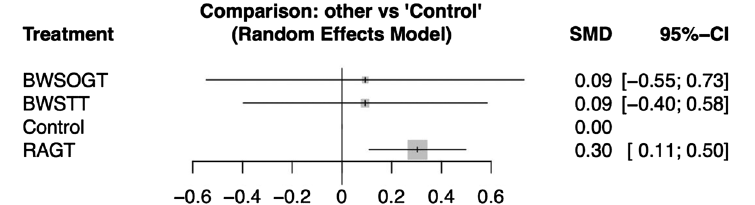
Figure 4. Forest plot of ambulatory assessments. The SMDs and 95% CIs of comparison between the control intervention and other body weight-supported gait training therapies were as follows: RAGT = 0.30 (0.11, 0.50); BWSTT = 0.09 (− 0.40, 0.58); and BWSOGT = 0.09 (− 0.55, 0.73). RAGT, robot-assisted gait training; BWSTT, body weight-supported treadmill training; BWSOGT, body weight-supported overground training; SMD, standard mean difference; 95% CI, 95% credible interval.